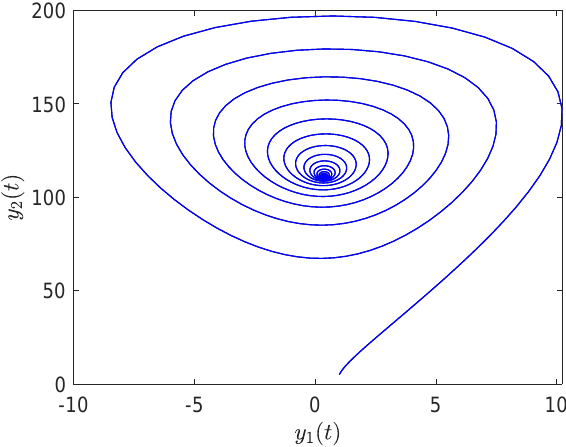
Figure 30. Phase portraits of y 1 and y 2 .